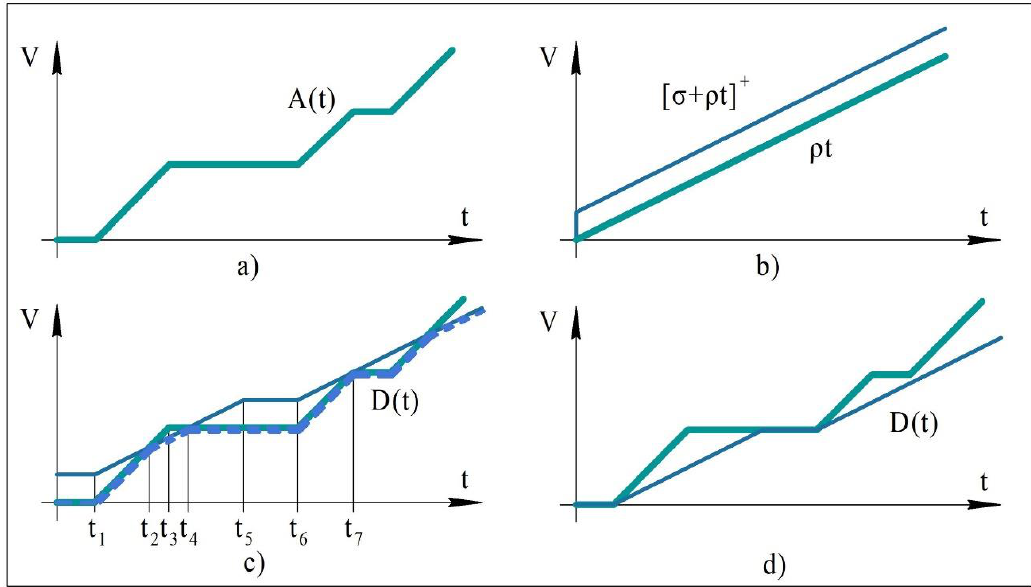
Figure 3. Building the departure function D  F under correspondence with the arrival function A  F by the shaper, working according to the flow algorithm